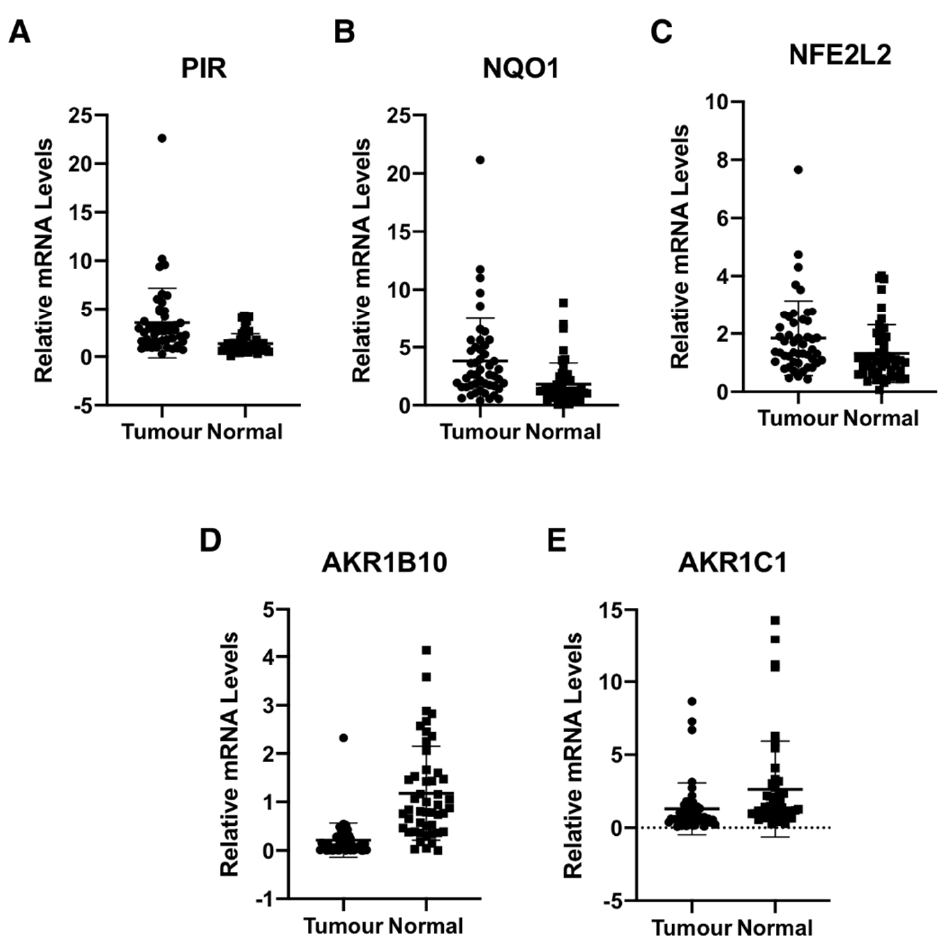
Figure 3. Pirin is overexpressed in human colorectal tumours. mRNA levels for pirin ( A ), NQO1 ( B ), NFE2L2 ( C ), AKR1B10 ( D ), and AKR1C1 ( E ) in matched tumour and normal tissues from human colorectal cancer patients ( n = 48). p < 0.05 in all cases. The TaqMan data were normalized using eukaryotic 18S rRNA (18S) as an internal control.